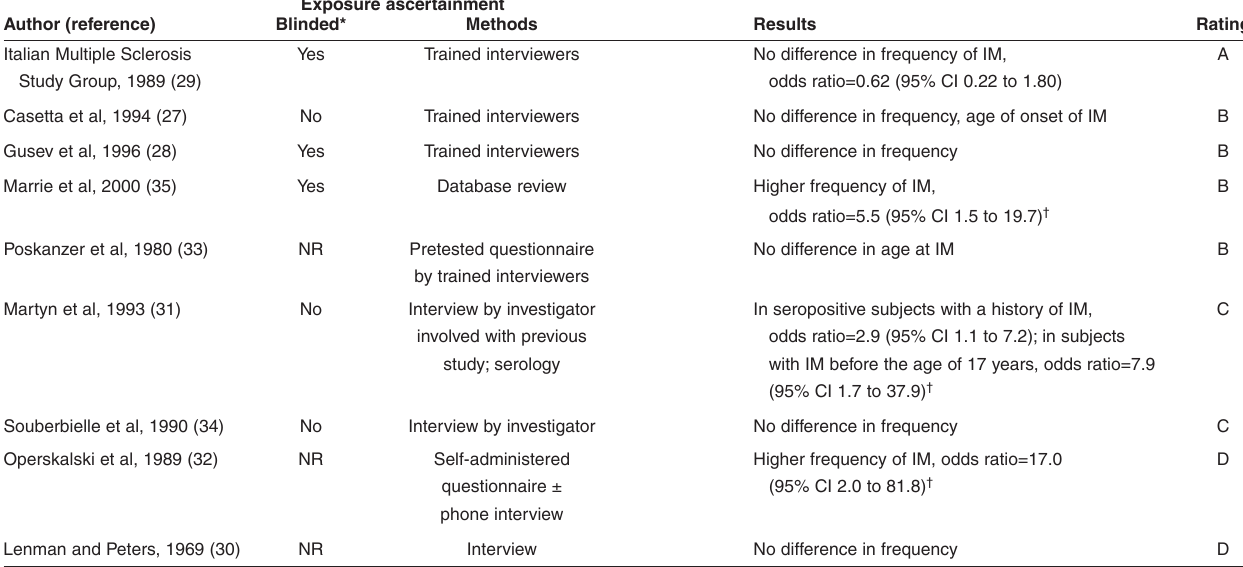
TABLE 4 Case-control studies – Methods and results